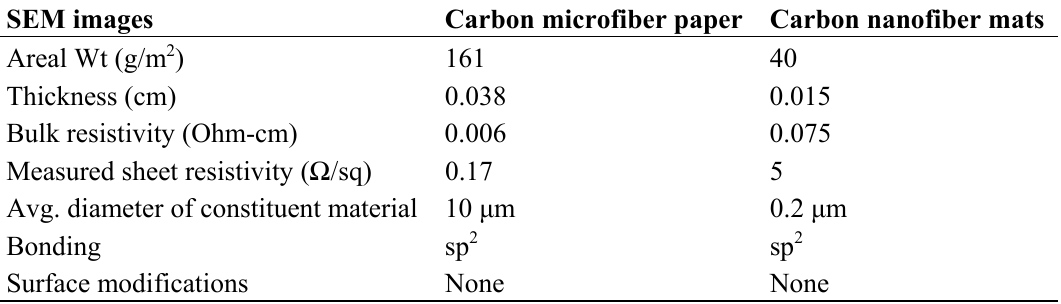
Table 1. SEM images of increasing magnification (2000×, 5000×, and 10,000×) of pristine carbon nanofiber mats ( A – C ); and carbon microfiber paper ( D – F